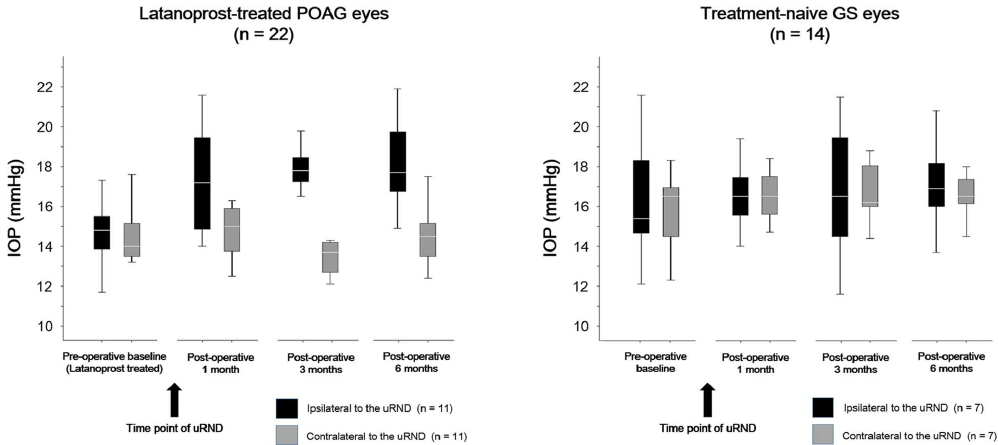
Fig 1. Comparisons of eyesipsilateral to unilateral radical neck dissection (uRND) with fellow eyesin terms of changes in intraocular pressure(IOP) between pre-operative baseline (prior to uRND) and post-operative follow-up visits (1, 3, and 6 months after uRND). POAG = primary open-angle glaucoma, GS = glaucoma suspect. * P = 0.015, ** P = 0.007, *** P = 0.004 (whencomparing post-operative IOP to pre-operativebaseline).